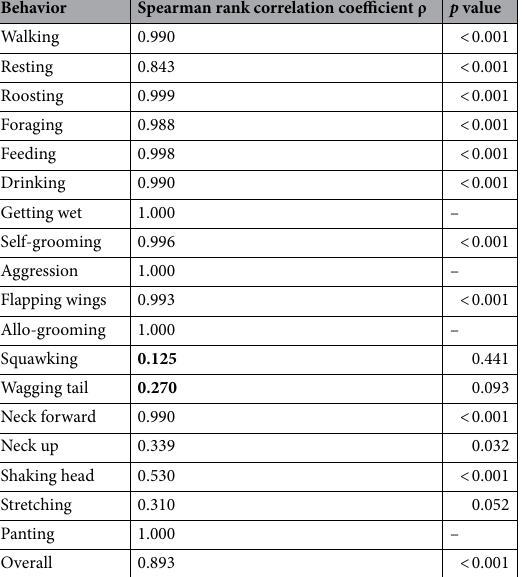
Table 4. Criterion validity. Spearman rank correlation coefficient (ρ) measuring the association between the frequencies obtained by the behavior observation form (BOF) in the field and the ‘gold standard’ measure (i.e., Noldus). Poor correlation coefficients (ρ < │ 0.3 │ ) are in bold. –Not computed as there was perfect association of